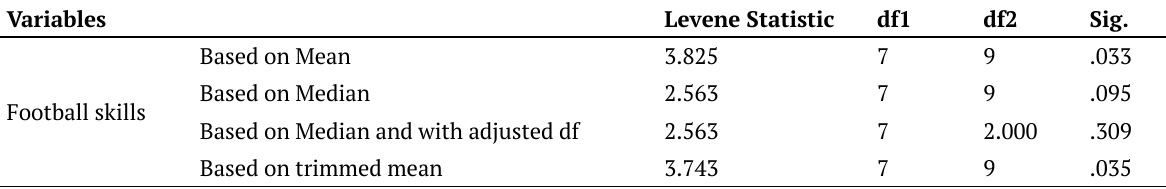
Table 4. The Speed towards the Football Skills Variables